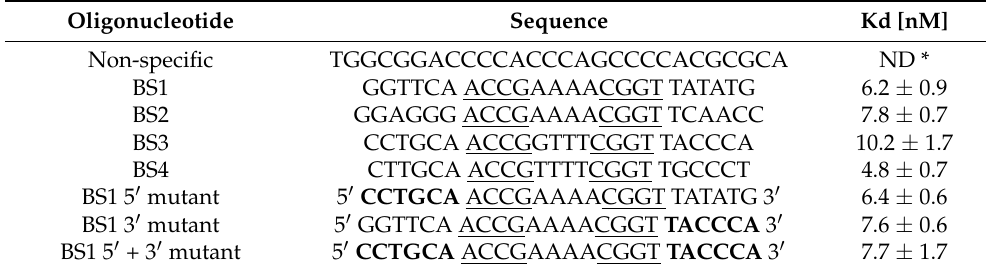
Table 1. Sequences for various oligonucleotides used as E2 binding sites and the associated dis- sociation constants are presented. Sequences for only one strand of each duplex oligonucleotide is shown. E2 consensus sequences are underlined. Mutant flanking sequences are bolded. Each K D was calculated and averaged from the experiment performed in triplicate. K D values represent the average of three independent measurements. Standard deviations were incorporated into K D, accordingly. * ND stands for “not